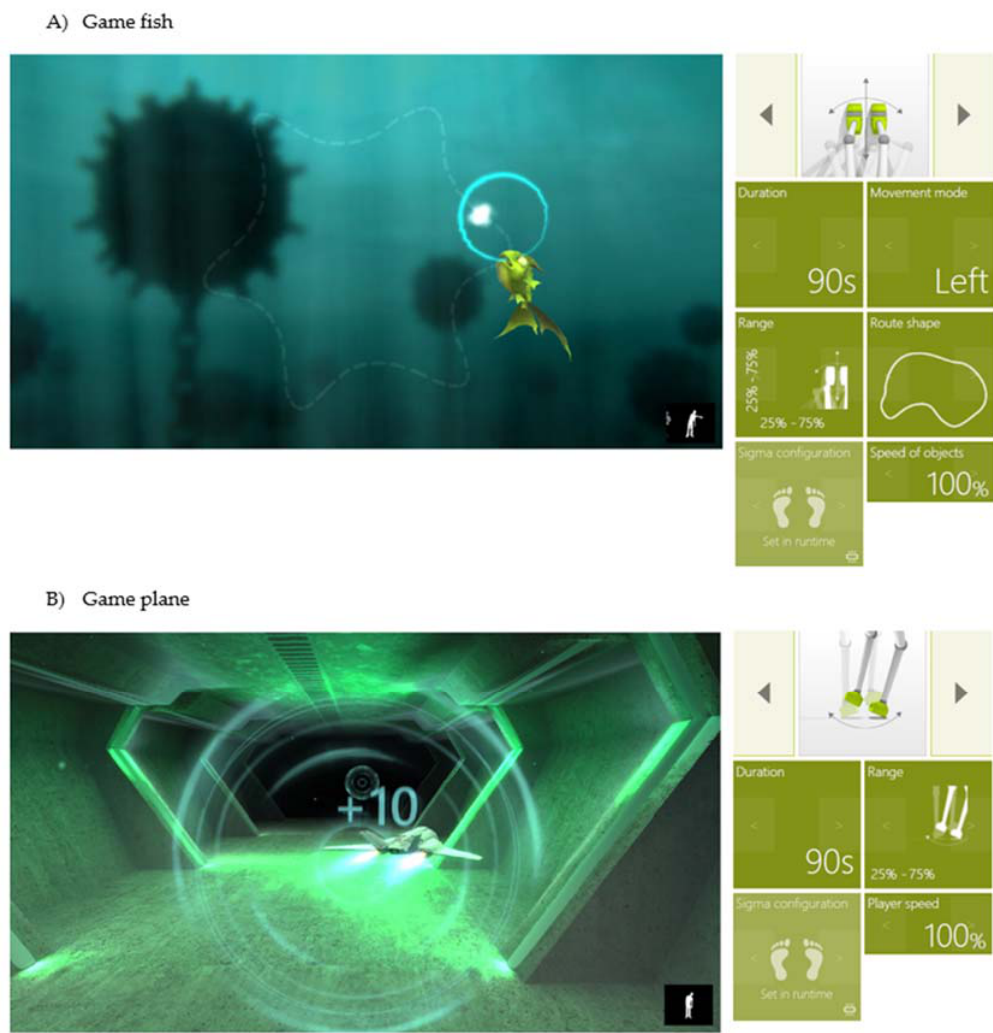
Figure 3. Sample settings for games ( A ) fish and ( B ) plane.